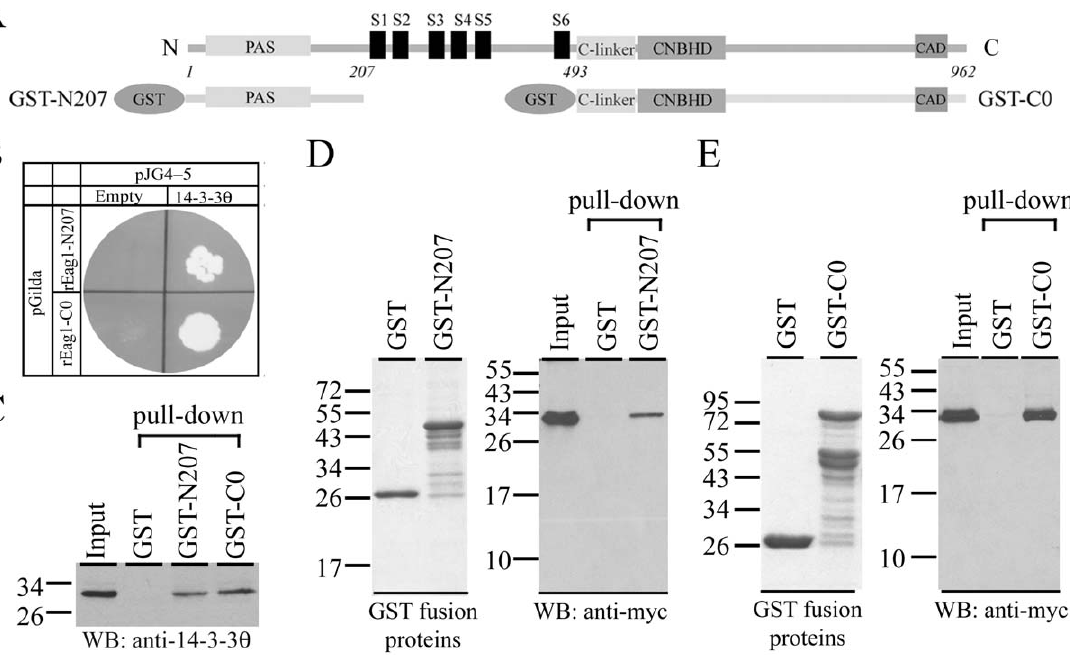
Figure 1. Interaction of rEag1 N- and C-termini with 14-3-3 h . ( A ) Schematic representation of ( top ) the structural topology of the rEag1 channel and ( bottom ) the rEag1 GST-N207 and GST-C0 fusion proteins. ( B ) Yeast two-hybrid assay. cDNA encoding rEag1-N207 or C0 segment was fused to the coding sequence for LexA DNA binding domain and subcloned into the pGilda vector. cDNA for the B42 transcriptional activation domain alone ( Empty ) or in combination with 14-3-3 h was subcloned into the pJG4-5 vector. Yeasts co-transformed with the pGilda- and the pJG4-5- based plasmids were streaked on leucine-lacking plates. ( C ) GST pull-down assay of in vitro translated 14-3-3 h . Pull-down products were immunoblotted with the anti-14-3-3 h antibody. Indicated to the left are the molecular weight markers (in kDa). ( D,E ) Cell lysates prepared from HEK293T cells expressing myc-14-3-3 h were used for GST pull-down assay with GST or the fusion protein GST-N207/GST-C0. ( Left panels ) Coomassie blue staining of the GST proteins. ( Right panels ) Immunoblotting of pull-down products with the anti-myc antibody. Input volume was 5% of that of the cell lysates for pull-down.